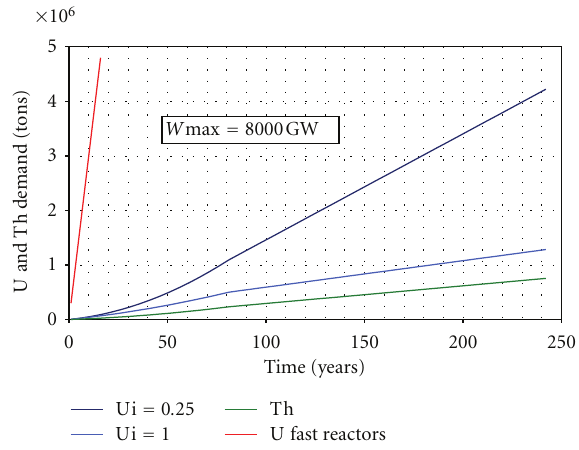
Figure 6: Dependencies of raw uranium requirement for di ff erent reactors at the stage of even power growth of nuclear power engi- neering to level of 8000 GW and further stabilization on this